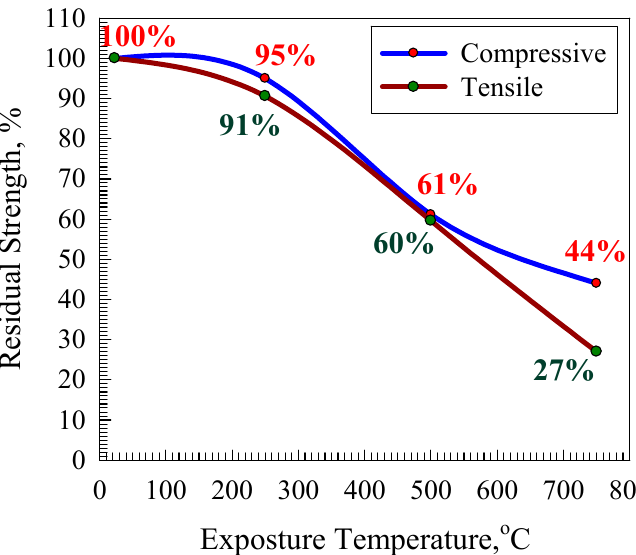
Figure 4. Residuals for compressive and splitting strengths.